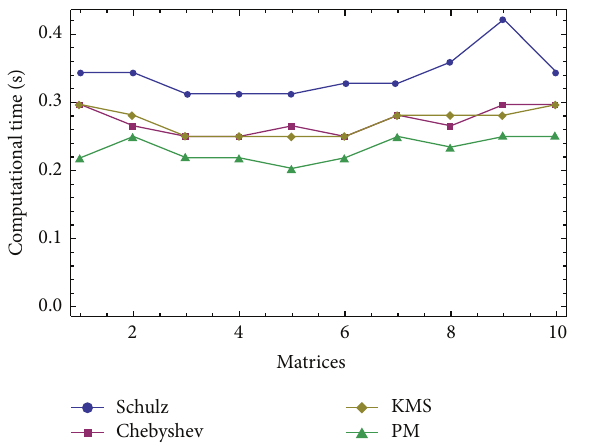
Figure 2: Comparison of the elapsed time for solving Example 8.